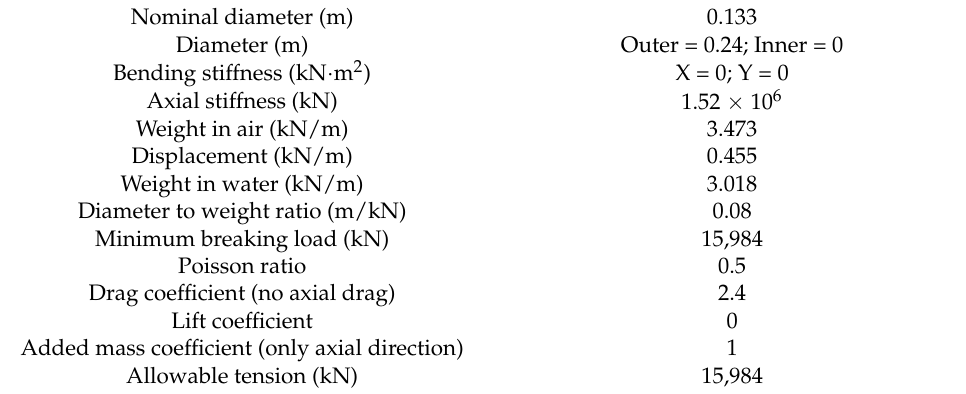
Figure 12. Illustration of single duct anchored on the seabed.